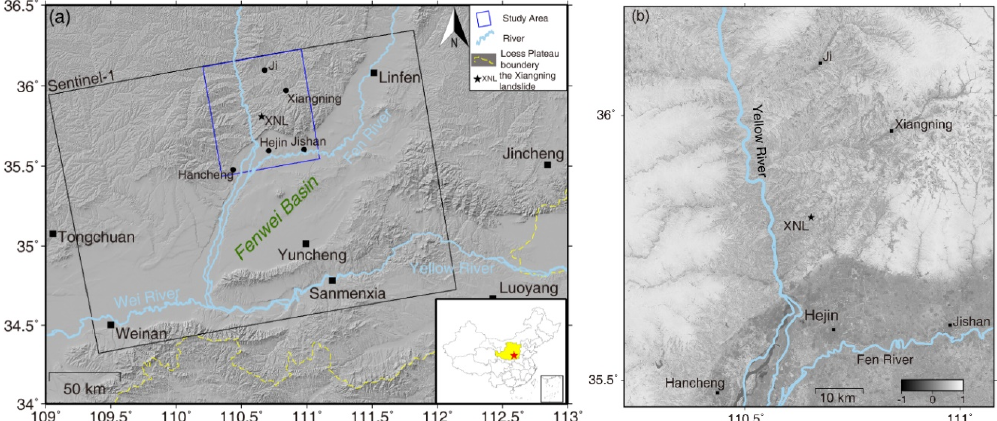
Figure 1. ( a ) Location of our study area. The yellow polygon and the red star in the inset represent the index (NDVI) map created from Sentinel-2 acquired on 5 June 2018.